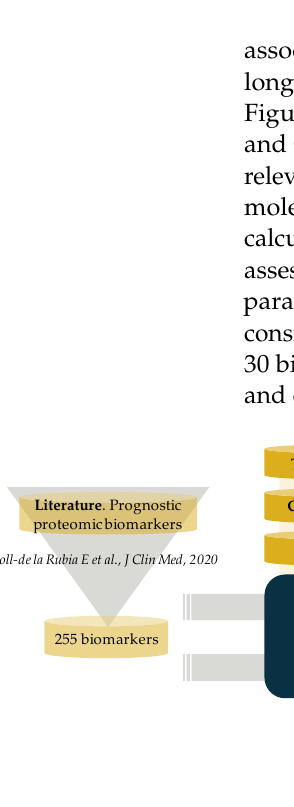
Figure 1. Workflow of the analysis. The 255 biomarkers compiled in Coll-de la Rubia E et al. 2020 [15] were assessed in two independent cohorts of patients from the TCGA and CPTAC studies. RNA-Seq data from both cohorts and proteomic data from the CPTAC cohort was used. Different prognostic factors were analyzed (histological type, histological grade, FIGO stage, Molecular classification), as well as overall survival and recurrence free survival. Finally, 30 biomarkers were identified as promising for the stratification of EC